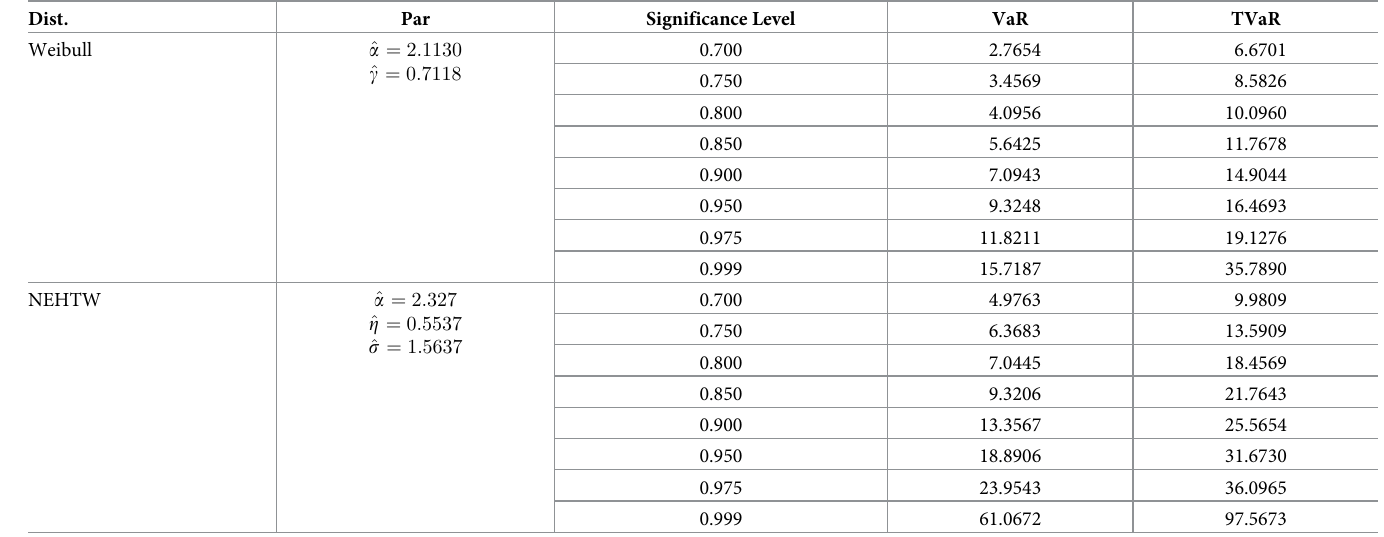
Table 13. The values of VaR and TVaR for earthquake insurance data. Dist.